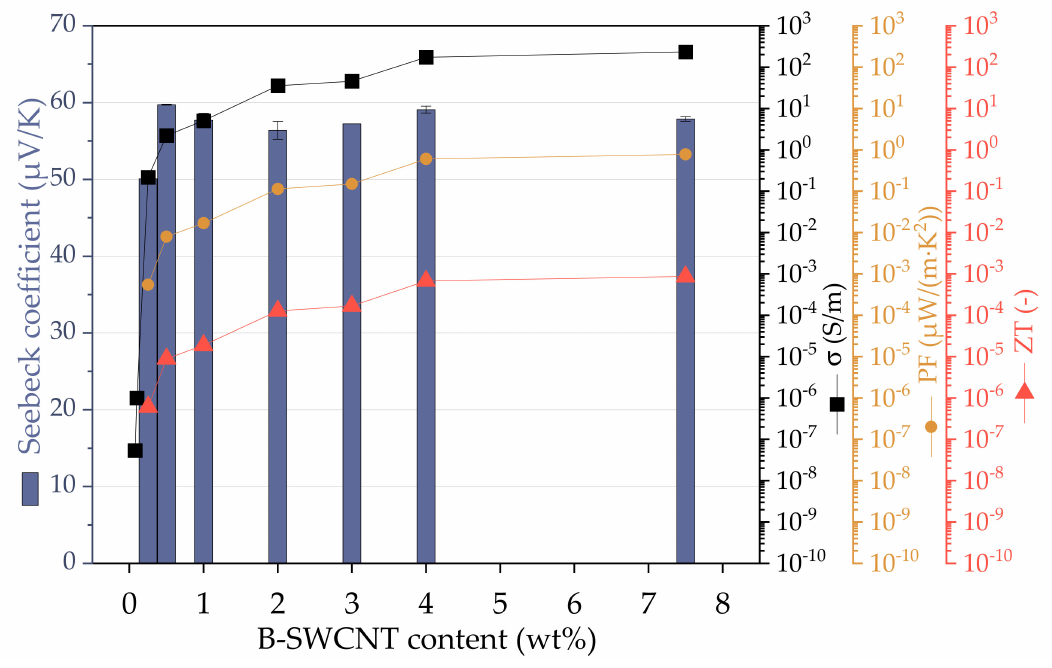
Figure 4. Thermoelectric parameters of PP / B-SWCNT composites at 40 ◦ C.